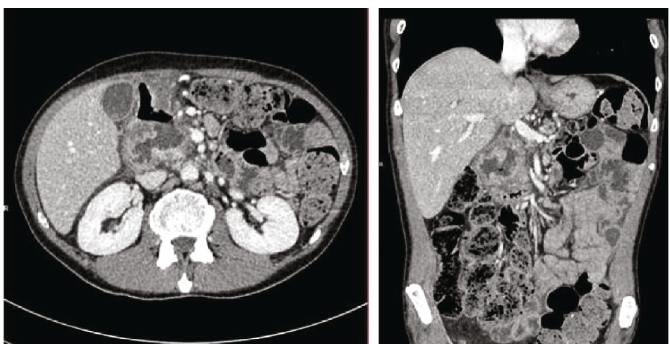
Figure 1: Computed tomography fi ndings: parietal thickening a ff ecting the antropyloric region and fi rst duodenal portion with an ulcerated appearance as well as trabeculation of the adjacent fat and the presence of adenopathies, initially interpreted as suspicious of a neoformative nature.